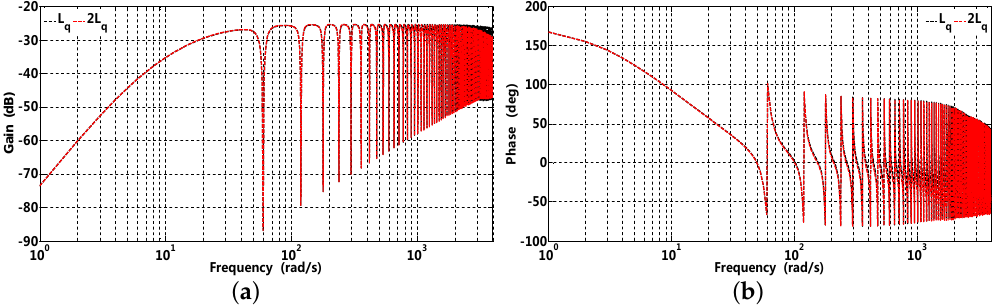
Figure 13. Gain and phase waveforms of q -axis sensitivity function with respect to inductance variation, where corresponding parameters are N = 1044, ω 0 = 60 rad/s, K q = 0.6, p = 3, D = 2.6 and T s = 0.1 ms, respectively. ( a ) L q ; ( b ) 2 ∗ L q